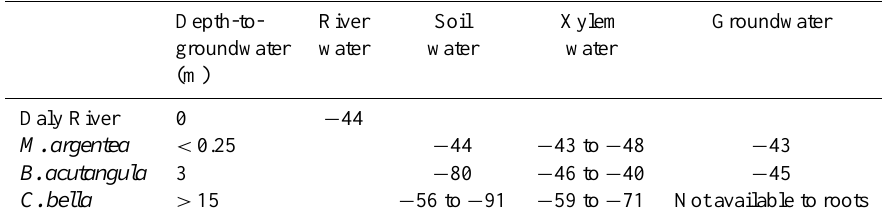
Table 1. Deuterium analysis of xylem, soil, river water and groundwater in a study of three species growing in the Northern Territory of Australia. The δ 2 H values (‰) of soil became more negative as distance from groundwater increased due to enrichment during surface evaporation. At shallow sites ( Melaleuca argentea ) the groundwater is near the surface and xylem water δ 2 H values match soil water and groundwater. As depth-to-groundwater increased (because of local topography: the site slopes up from the river) xylem water isotope composition was increasingly more negative than groundwater because groundwater was unavailable to the roots. From Lamontagne et al.